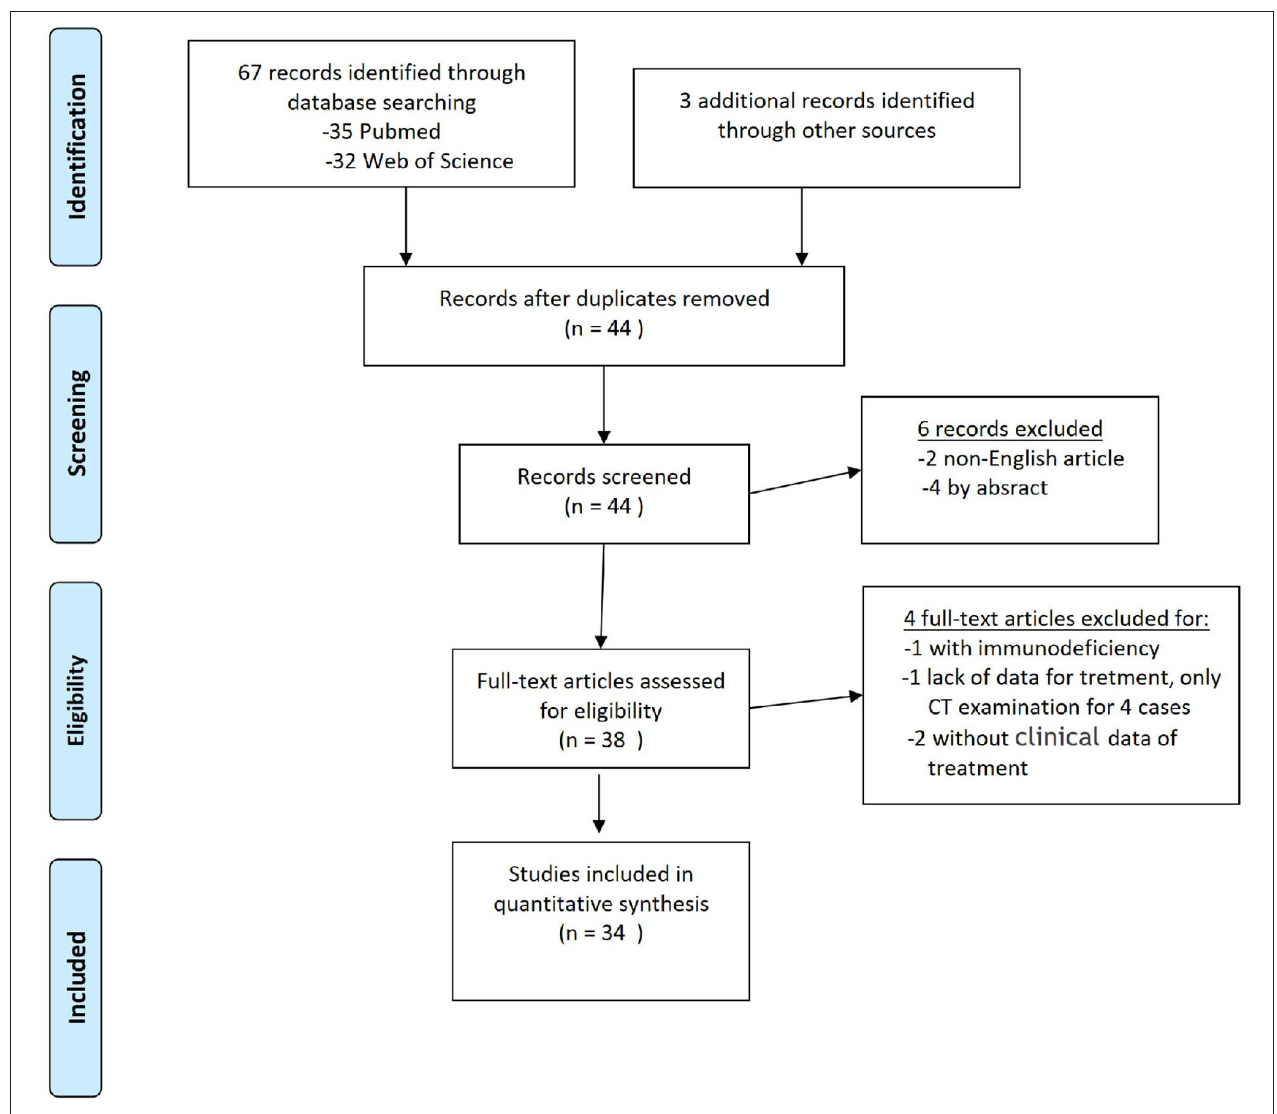
FIGURE 1 | PRISMA flow diagram for literature search. From Moher et al. (5).